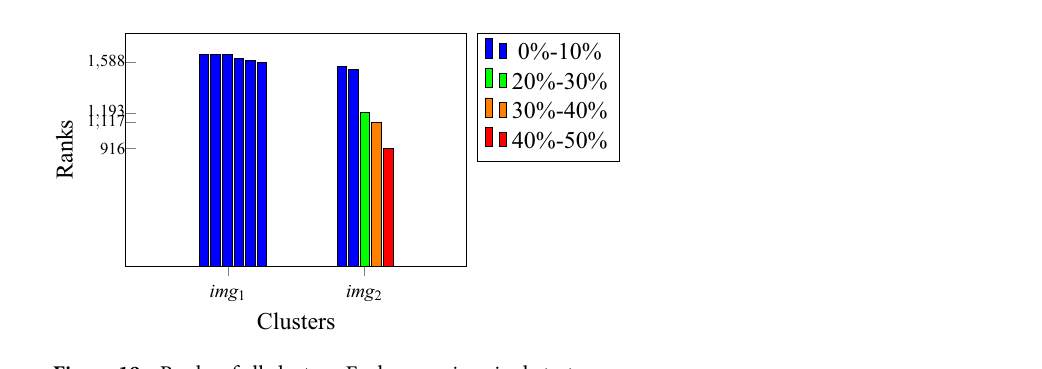
Figure 19. Ranks of all clusters. Each group is a single test